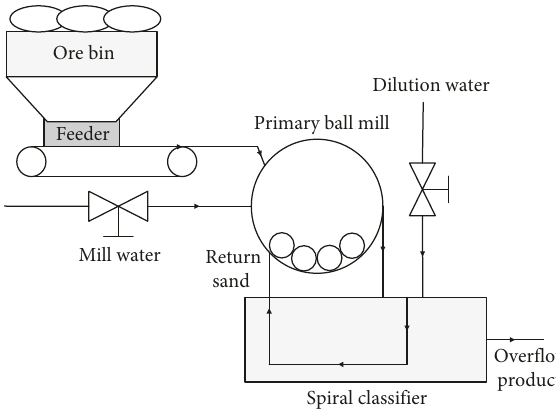
Figure 1: The grinding process of the primary ball